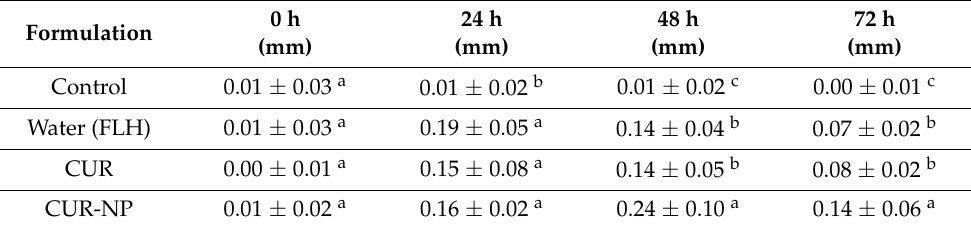
Table 3. Delayed-type hypersensitivy (DTH) test expressed as change in footpad thickness for each treatment measured at 0, 24, 48 and 72 h. 1,2